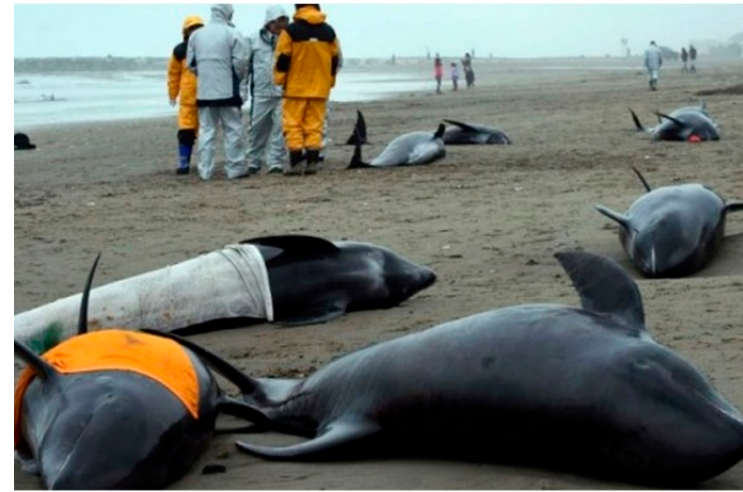
Figure A3. Stimulus Image for the Animal Health Message.